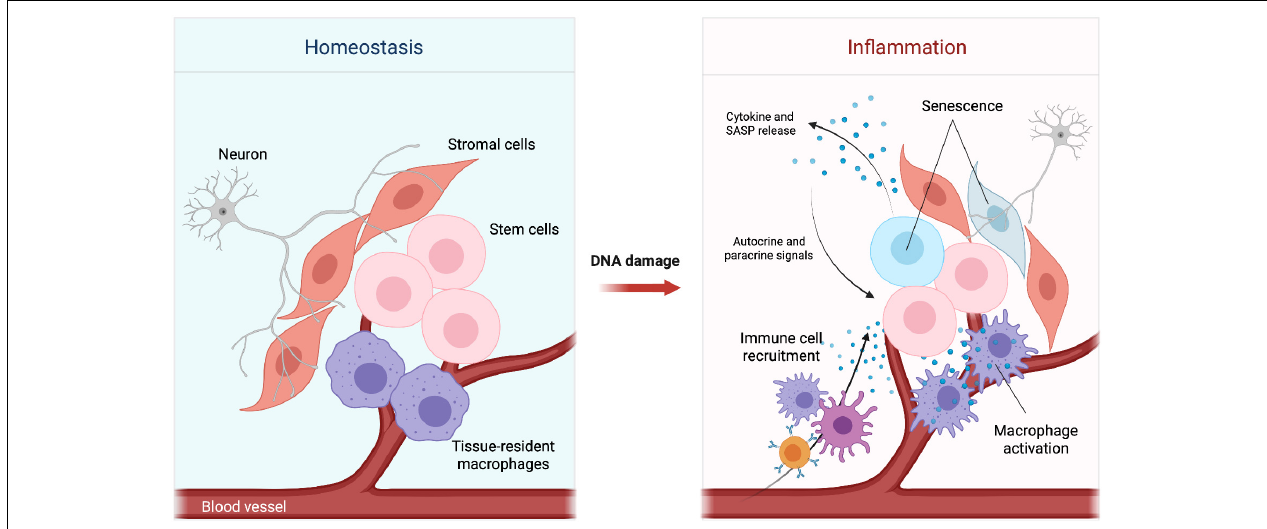
FIGURE 1 | Changes in the stem cell microenvironment upon DNA damage. Simplified schematic representation of the tissue microenvironment during homeostasis (Left) and inflammation (Right) . DNA damage can impair tissue homeostasis by promoting senescence, cytokine and SASP release. Cytokines and chemokines present in the microenvironment can lead to recruitment of immune cells and activation of tissue-resident macrophages.